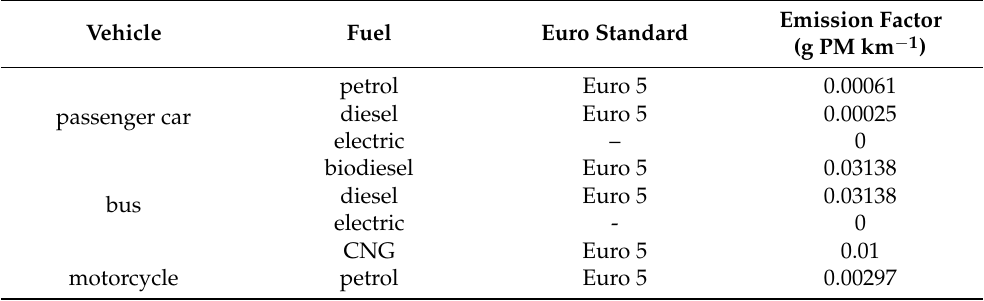
Table 5. Emission factors of sample motorized transport modes, fuel types, and Euro standards.